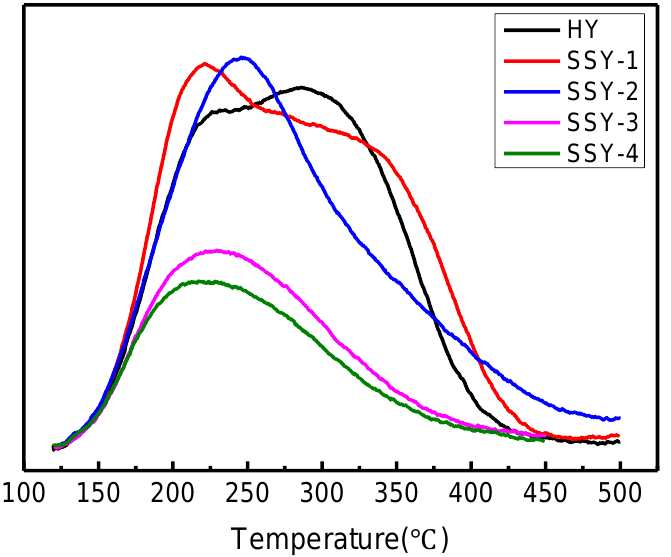
Figure 3. TPD spectra of parent HY and ammonium hexafluorosilicate modified zeolites.